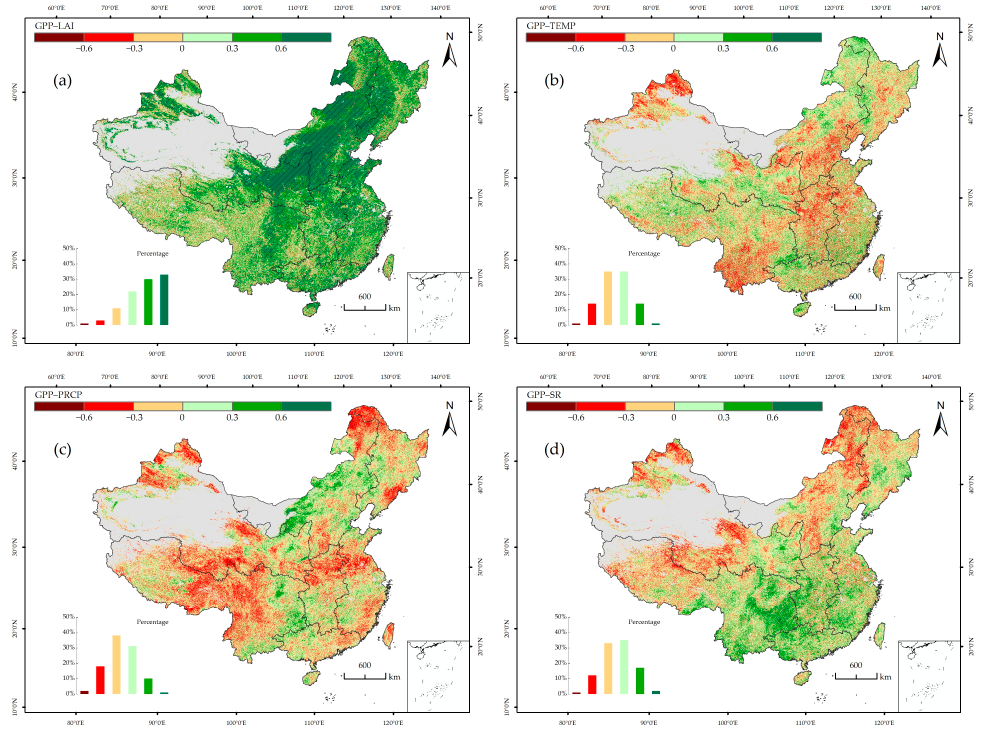
Figure 10. Partial correlations and spatial distributions of significance ( p < 0.05) between the GPP and the ( a ) LAI, ( b ) temperature, ( c ) precipitation, and ( d ) solar radiation. The statistics of the average correlation coefficients and standard deviations of the GPP with LAI, TEMP, PRCP, and SR correlations in the different regions are presented in Figure 11. Compared with the other correlations, GPP-LAI exhibited a stronger correlation in all of the regions, especially NW, NC, and NE. The average correlation coefficient of GPP- TEMP was negative in NC, CC, and NW, indicating that the increase in TEMP inhibited the carbon sequestration capacity of the three regions. It should be noted that the average correlation coefficient of GPP-PRCP was only positive in NC. The average correlation coefficients of GPP-SR in the different regions ranked as follows: SC > CC > EC > SW > NW > NC > NE. Moreover, the regions with positive correlations were all located in southern